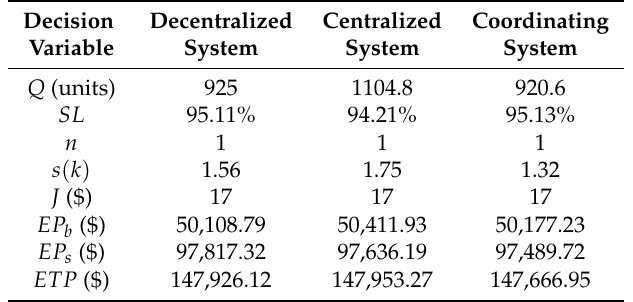
Table 2. Output data for numerical problem 1, in case of unreliable seller.